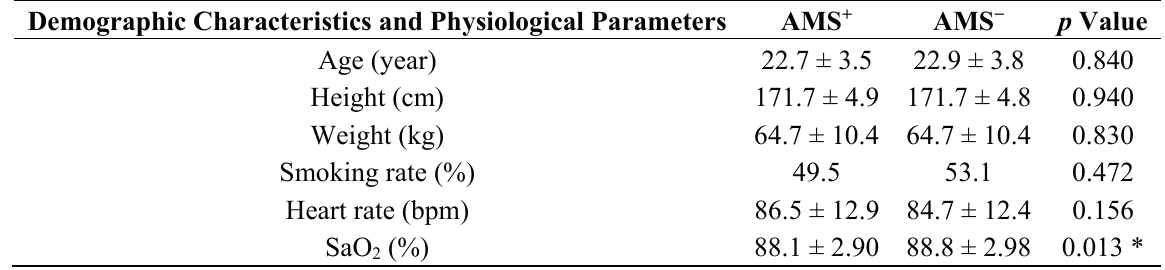
Table 1. Demographic characteristics and physiological parameters of study population. Demographic Characteristics and Physiological